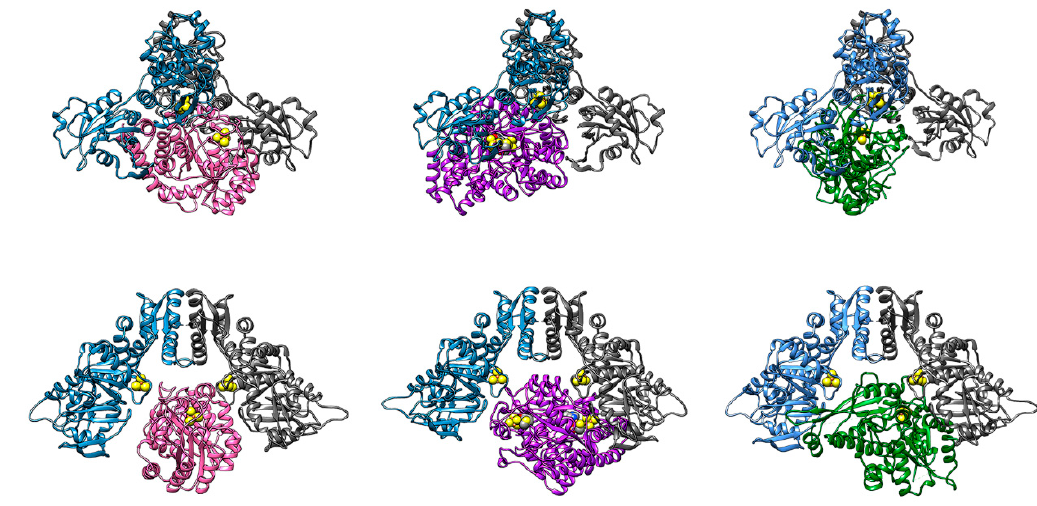
Figure 6. Molecular docking of reconstructed HydF from T. melaniensis (monomers in blue and grey) with: left, HydE (pink) from T. maritima (pdb.id 3CIW); center, HydG (purple) from T. italicus (pdb.id 4WCX); right, HydA (green) from C. reinhardtii (pdb.id 3LX4). Top and bottom show two views of the same docking pose rotated by 90°. All proteins show the active FeS clusters in sphere representation.